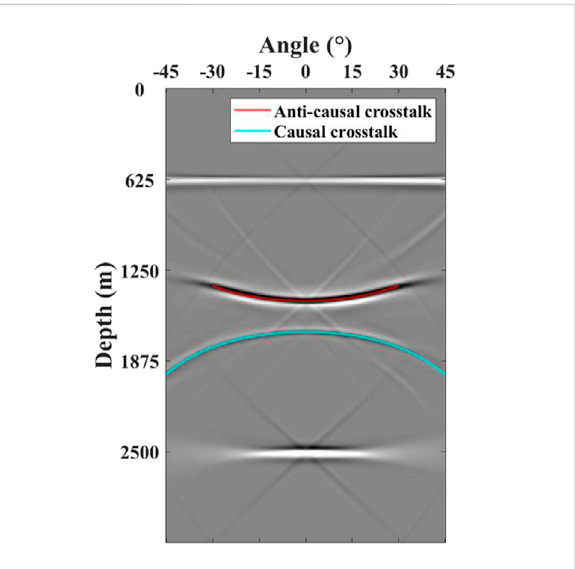
FIGURE 8 Twotypesofcrosstalkinanglegathers.Theredsolidandthelight blue line represent the calculated anti-causal crosstalk and causal crosstalk, respectively.